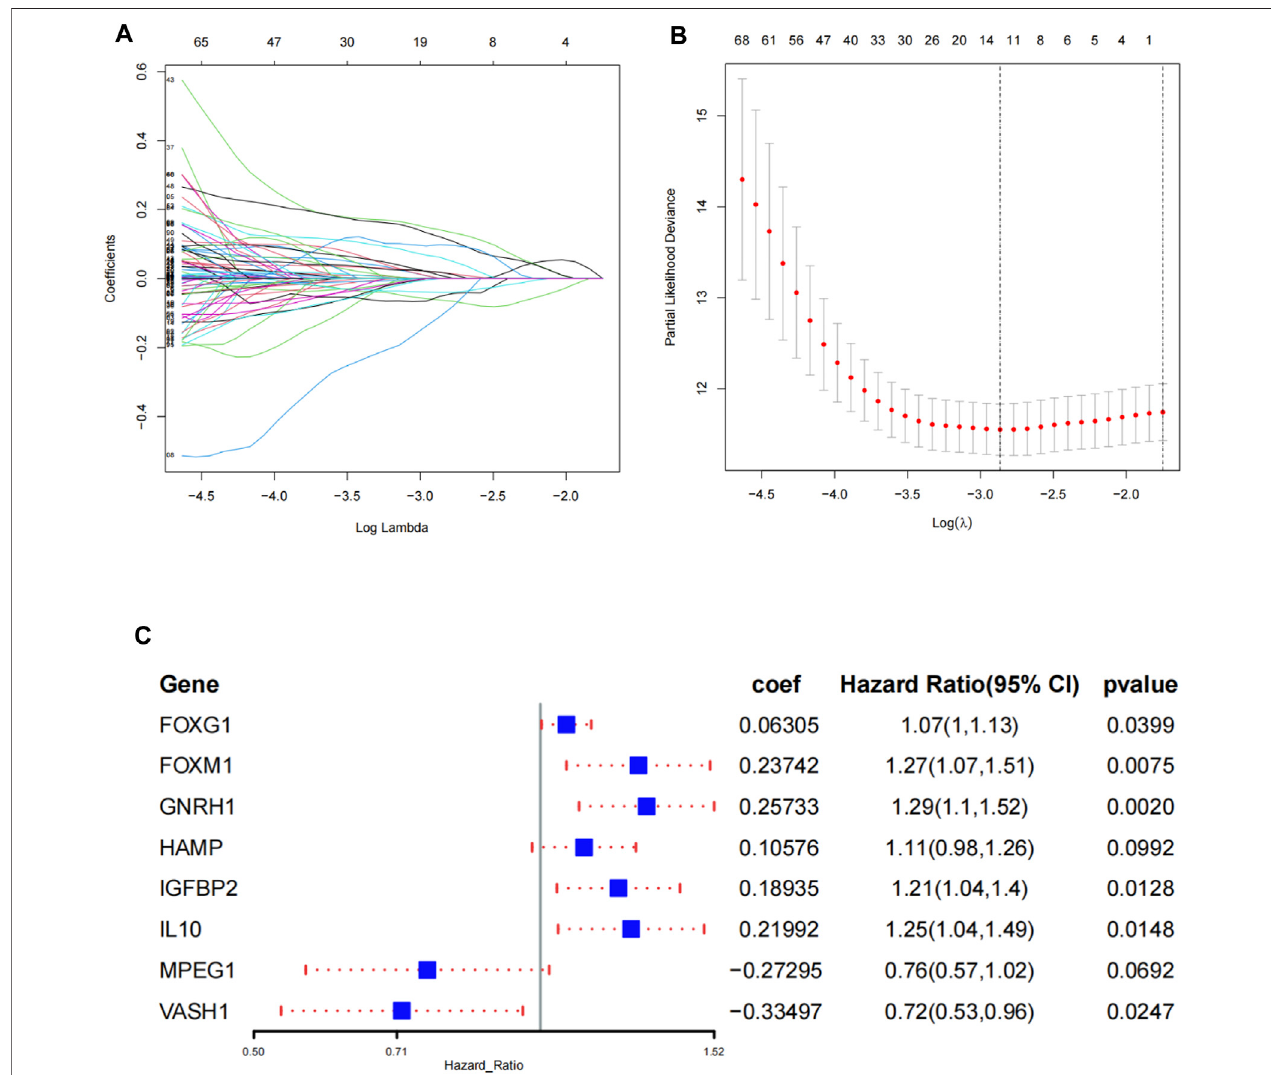
FIGURE 1 | Construction of the prognostic signature in TCGA. (A) Select the optimal parameter (lambda) in the least absolute shrinkage and selection operator (LASSO) model. (B) LASSO coef fi cient pro fi les of the 12 prognosis-associated ASRGs with non-zero coef fi cients determined by the optimal lambda. (C) Identify eight ASRGs to construct a risk signature by the multivariate Cox regression